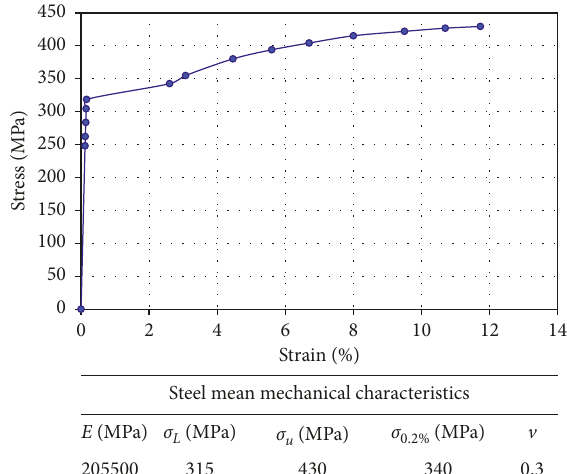
Figure 4: Tensile curve and mean characteristics of mild